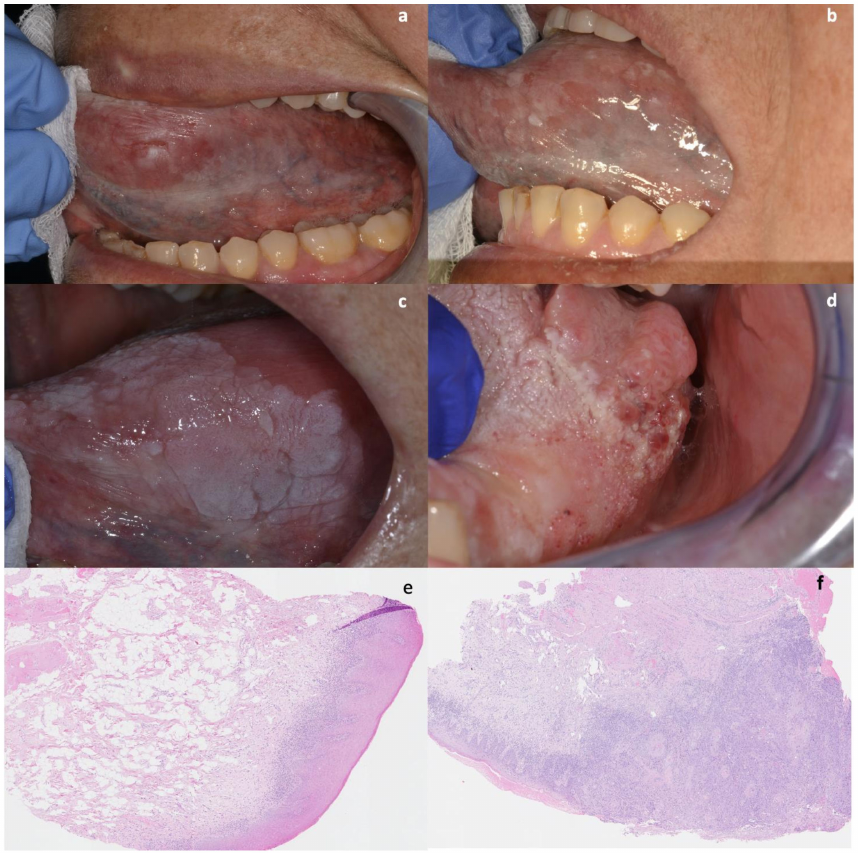
Figure 1. Evolution of OLP lesions on the left lateral border of the tongue of a female patient ( a = 2012; b = 2014; c = 2015; d = 2017, date of cancer diagnosis; e = initial histopathological evaluation in 2021, f = OSCC diagnosis in 2017). This patient had also at onset typical reticular lesions on buccal mucosae.